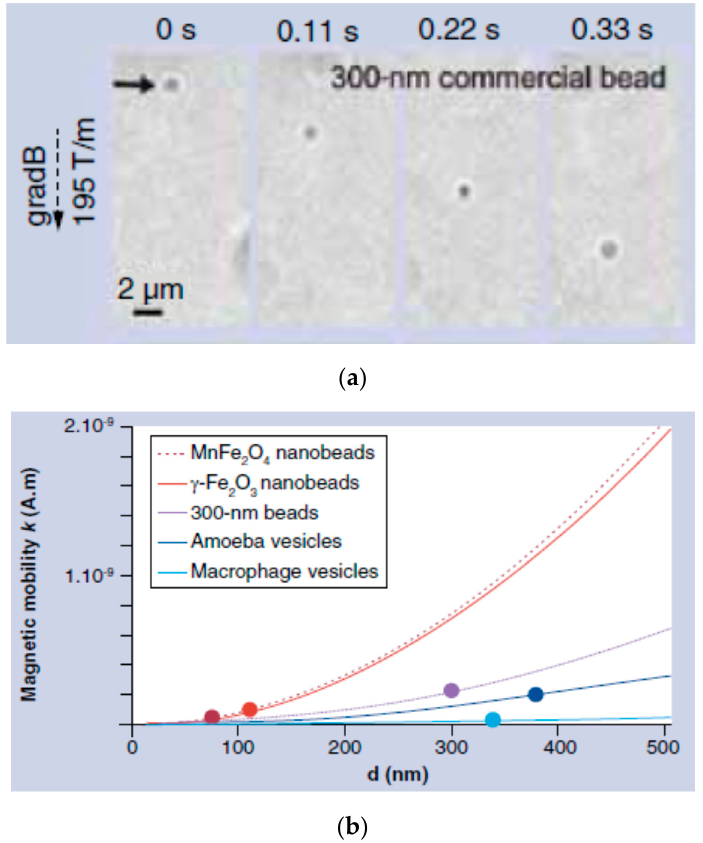
Figure 25. ( a ) Multi-core magnetic composite (MMC) moving in the 195 T / m zone, and ( b )